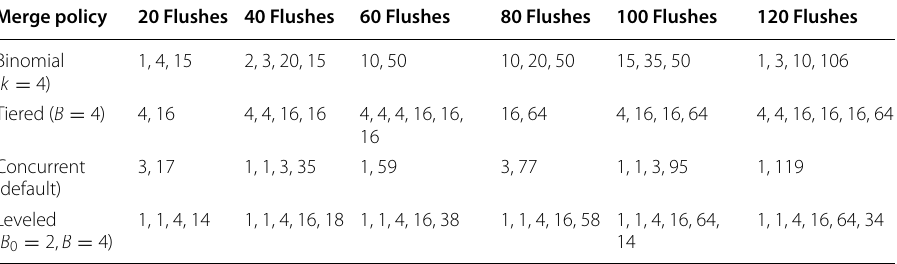
Table 1 Sorted run sizes of the four compared merge policies, where newer sorted runs are on the left